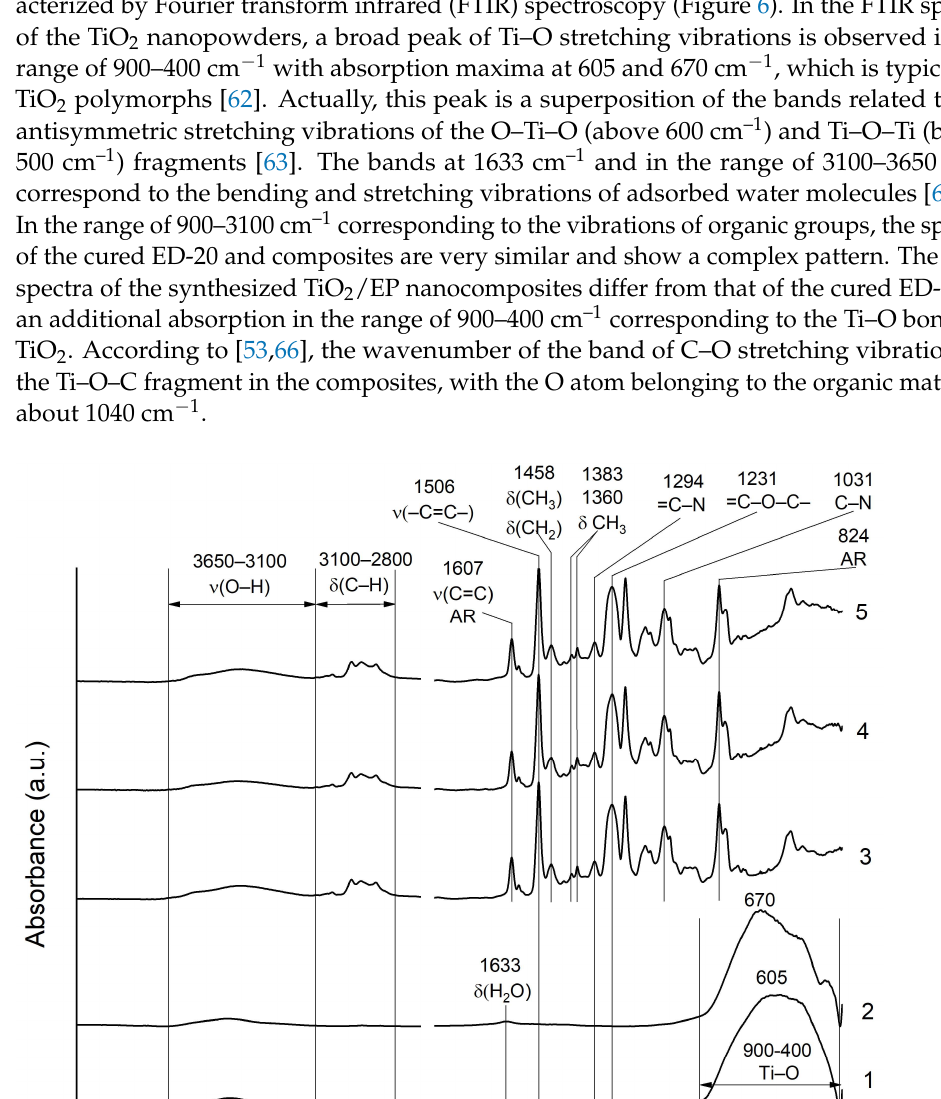
Figure 5. XRD patterns: 1—TiO 2 ( d av = 46 nm); 2—TiO 2 ( d av = 100 nm); 3—cured epoxy; 4—TiO 2 /EP of System I (4 wt. % TiO 2 ); and 5—TiO 2 /EP of System II (4 wt. % TiO 2 ). The following symbols are used: A—anatase, R—rutile, and E—cured epoxy resin.